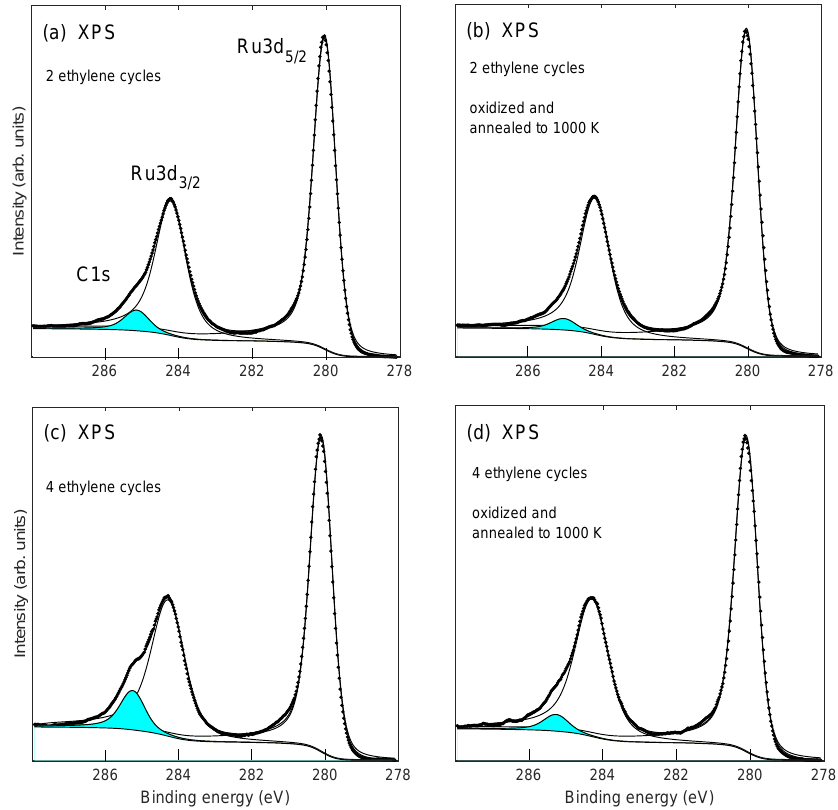
Figure 7. Ru3d and C1s XPS after 2 and 4 ethylene exposure cycles to Ru(0001), panels ( a , c ). Panels ( b , d ) show spectra that were recorded after annealing to 1000 K of the oxidized systems. Solid lines show deconvoluted spectra. The filled peak near-binding energy 285.2 eV in each panel is identified as C1s emission. The electron emission angle with respect to the surface normal was set at 70 ◦ to enhance the surface